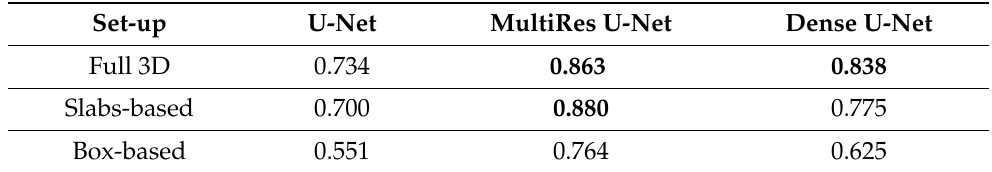
Table 3. Dice score results on slabs and full volumes.